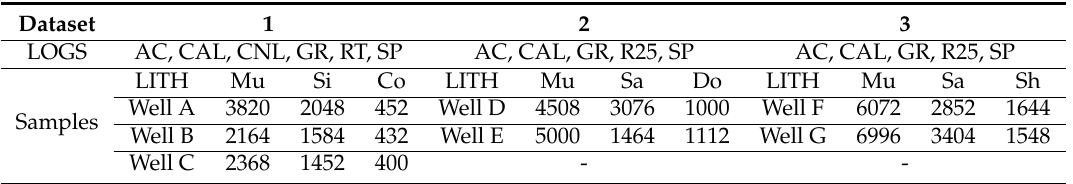
Table 1. Dataset description.